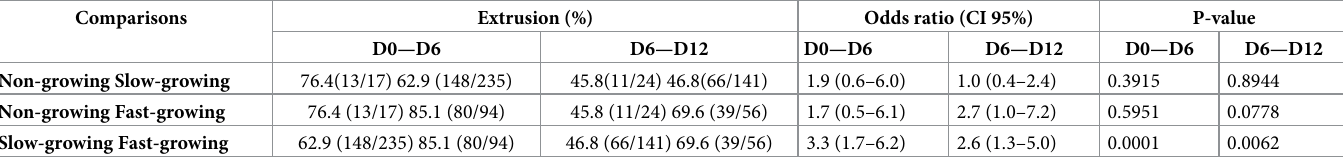
Table 4. Association analyses between follicular growth categories and percentage of extrusion in different intervals of in vitro follicle culture.